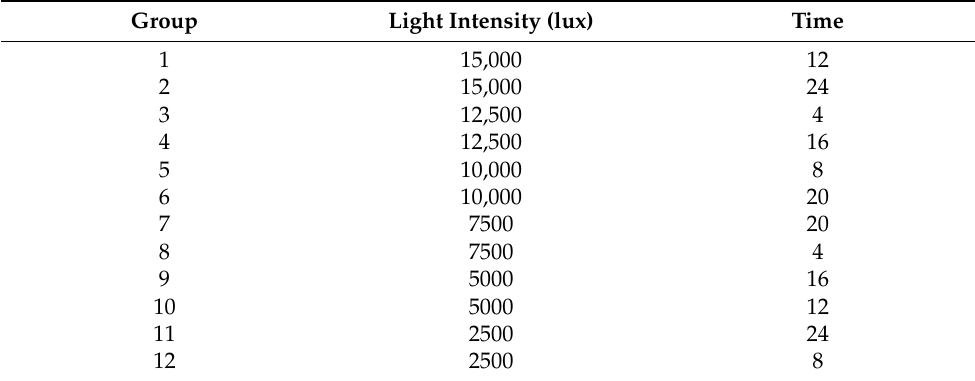
Table 5. The uniform design of the effect of light intensity and daily light period on Scenedesmus dimorphus